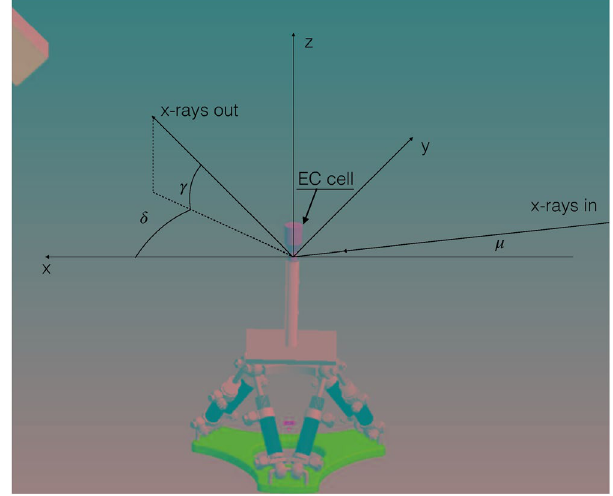
Figure 1. Schematic layout of the SXRD experiment. In SXRD the reference system is referred to the sample surface with the x- and y-axes laying on the sample surface while the z-axis is perpendicular to it. The x axis is along the projection in the x,y plane of the incident X-ray beam. The hexagonal surface cell of the Ag(111) is used as orientation matrix during the experiment. The a and b vectors are in the the surface plane while the c vector is parallel to the z-axis. In a SXRD experiment the angle of incidence μ is kept at a constant value (1° in our experiment). Once the orientation matrix of the sample is defined a point of the reciprocal space can be reached by moving the gamma, delta and omega angles. The software takes care of calculating the diffractometer angles for any particular scan in the reciprocal